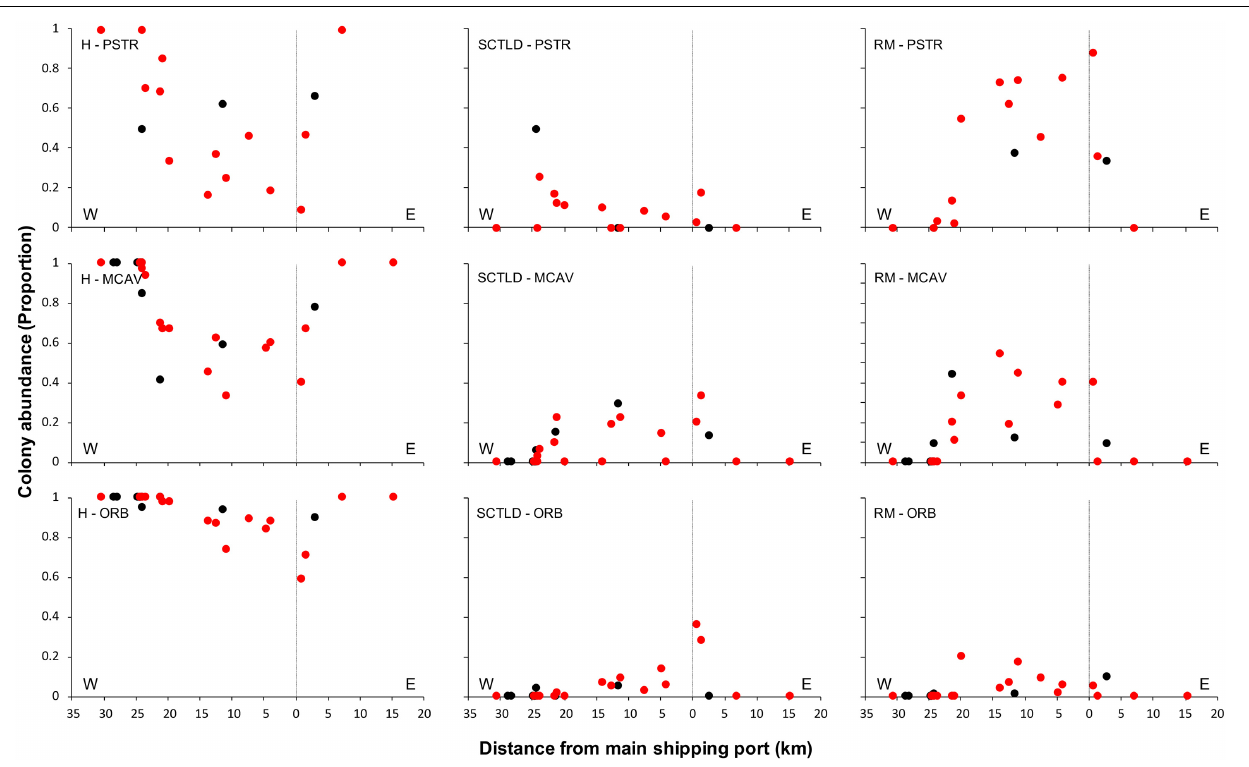
FIGURE 4 | Proportion of colonies from New Providence that were healthy (H, left), infected with SCTLD (middle), or experienced recent mortality (RM, right) for Pseudodiploria strigosa (PSTR), Montastraea cavernosa (MCAV), and Orbicella spp. (ORB) plotted against distance east and west of the port facility (distance = 0). Deep reefs ( > 10 m) are shown in black and shallow reefs ( ≤ 10 m) in